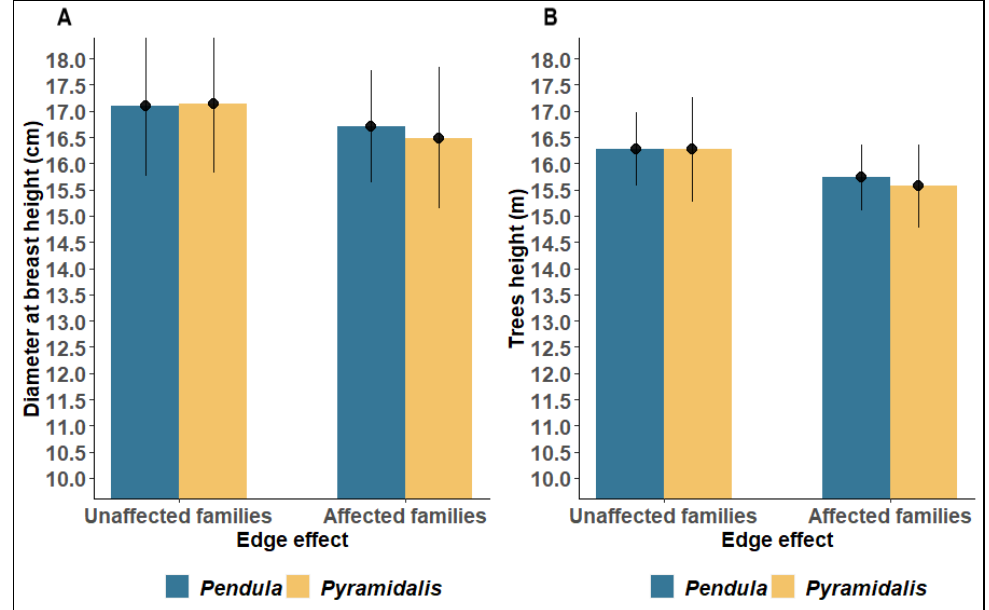
Figure 7. Variation in the growth traits: diameter at breast height ( A ) and tree height ( B ) by the edge effect. The black vertical lines represent the standard deviation.